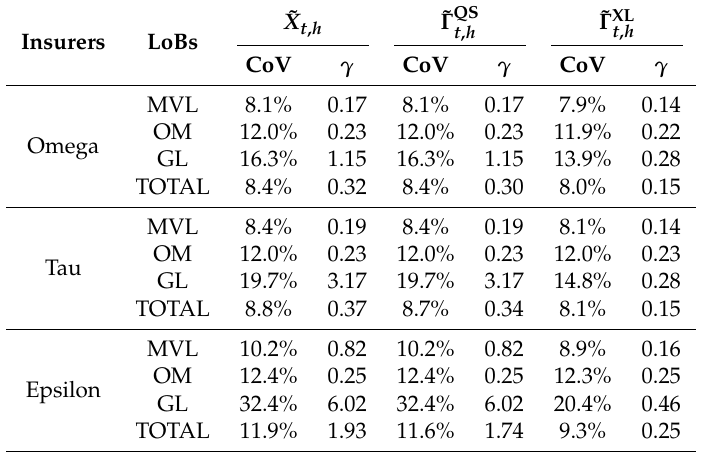
Table 5. Coefficient of variation (CoV) and skewness of simulated distribution for each LoB (Baseline Portfolio